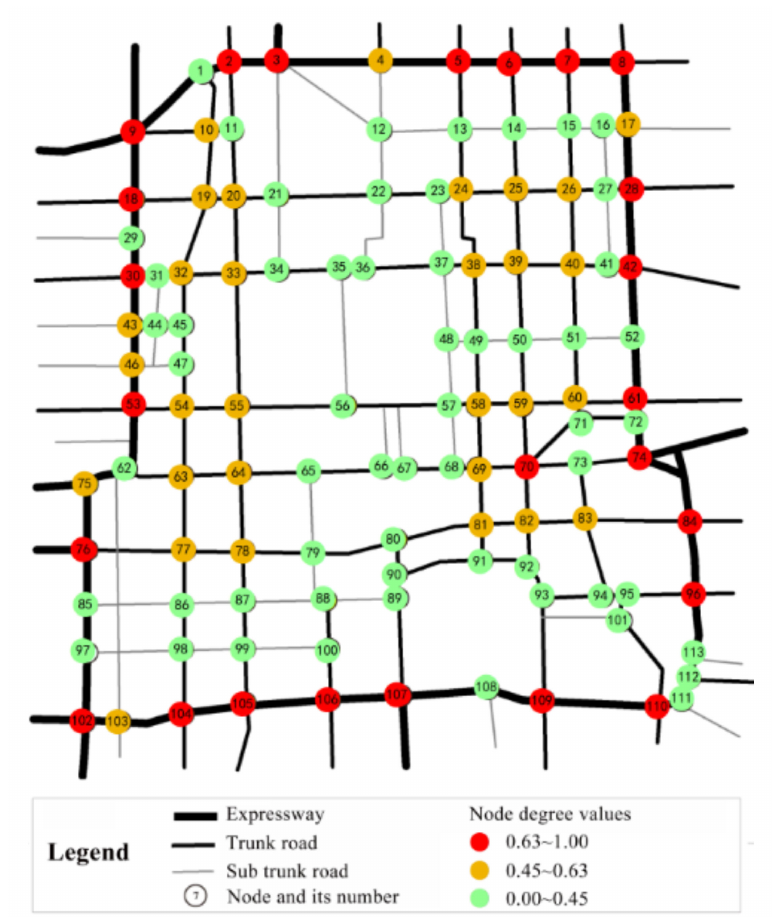
Figure 5. Spatial distribution of node